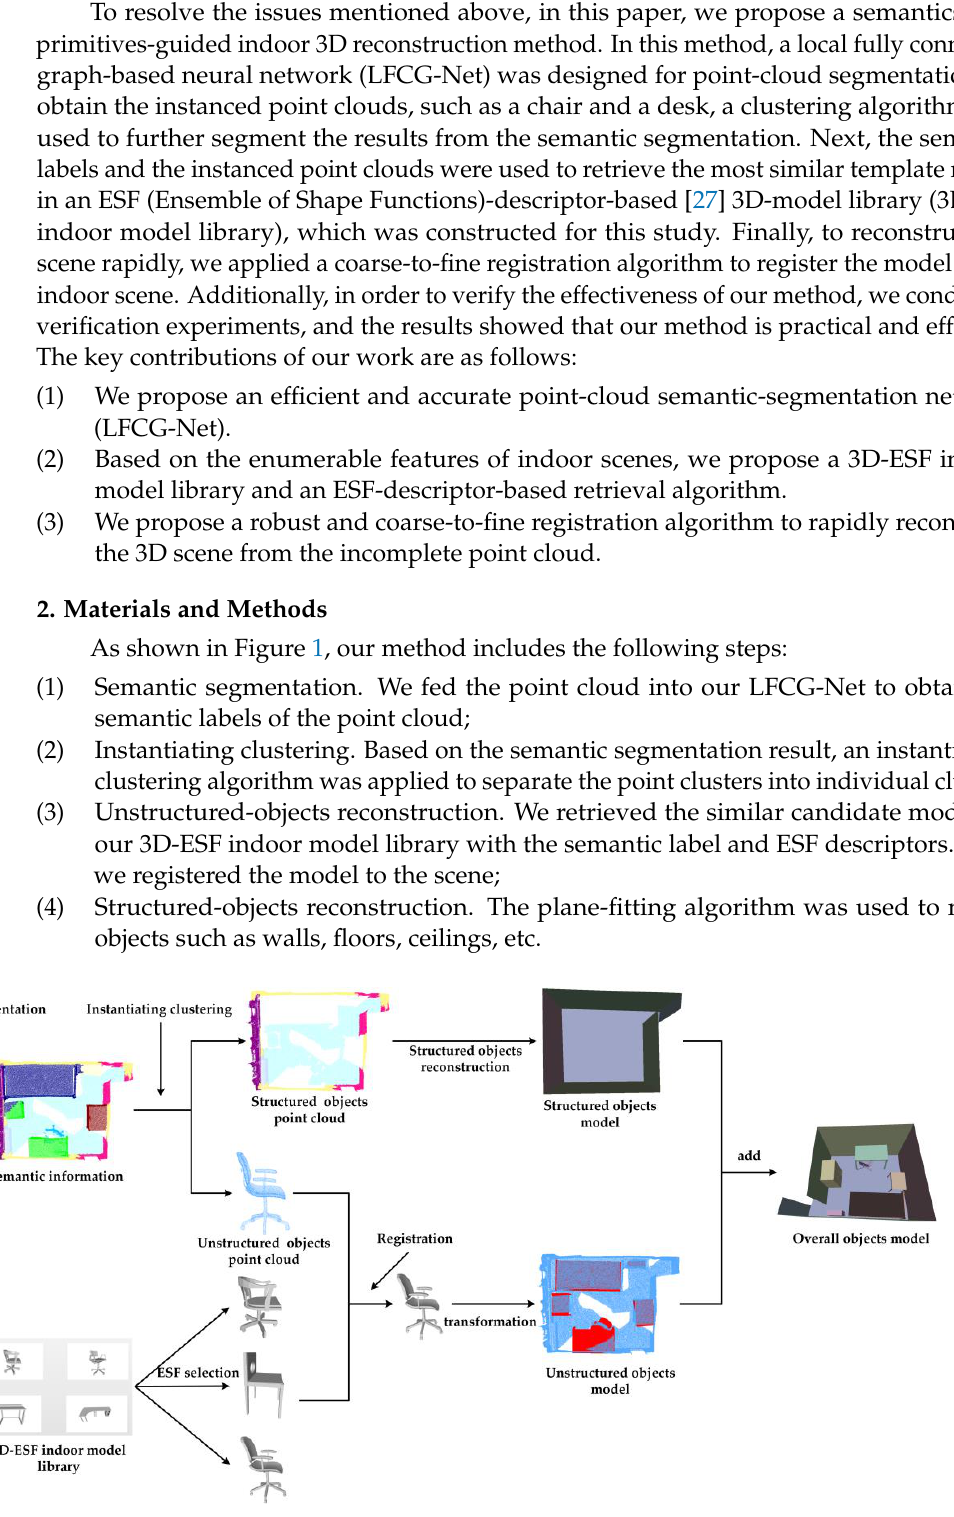
Figure 1. Flowchart of automatic semantic modeling of indoor point